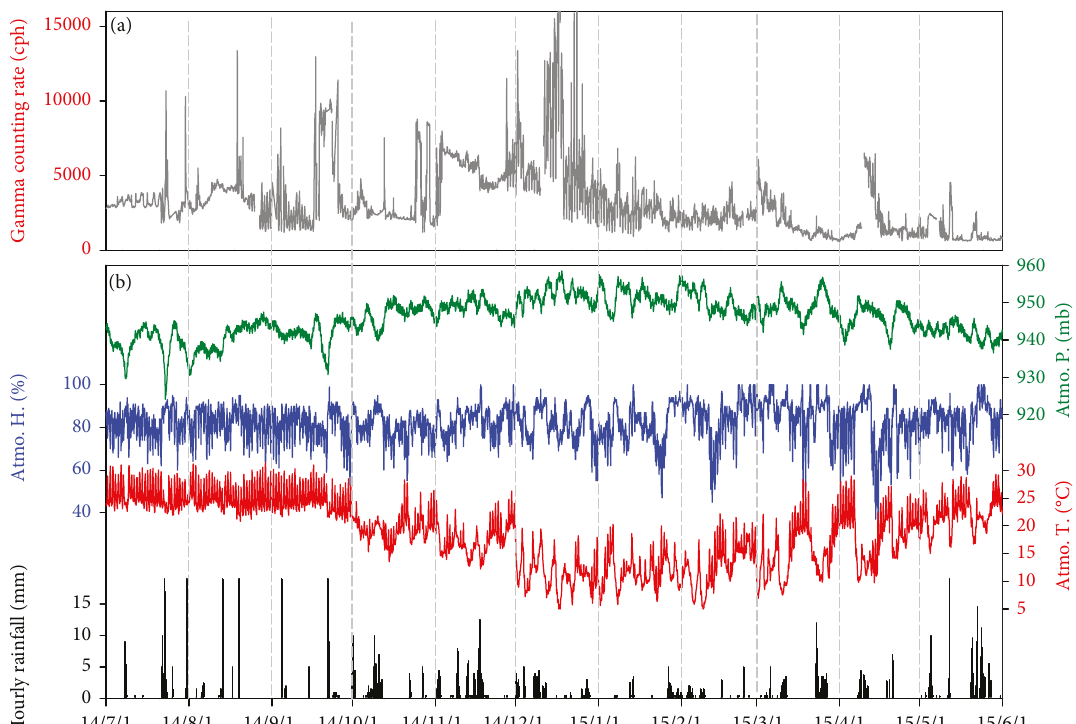
Figure 3: Temporal variations of gamma rays at the YMSG station (a) and (b) atmospheric data, including atmospheric pressure (green), humidity (blue), temperature (red), and hourly rainfall (black) (b) from July 1, 2014, to June 1,